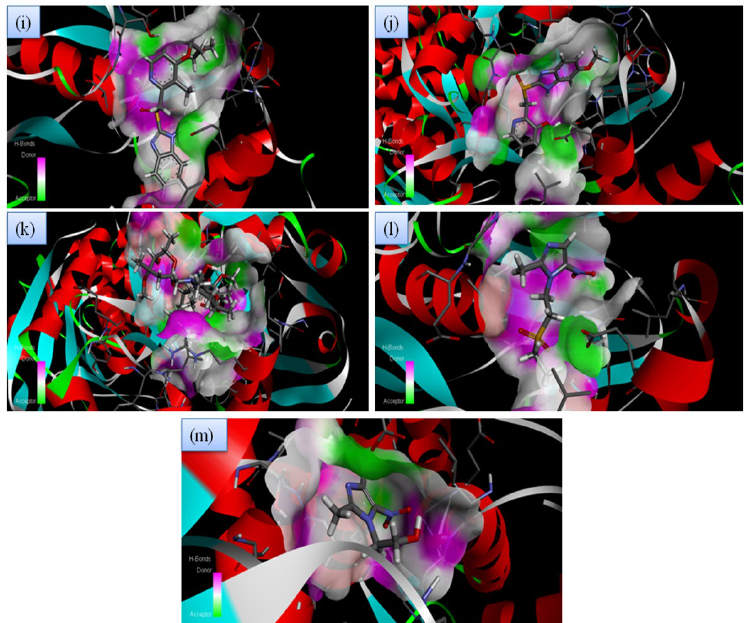
Fig. 3C. H-Bonding interaction of compound with the active site of Chorismate synthase protein (1UMF). (i) Rabeprazole (RBP) (j). Pantoprazole (PPZ). (k) Clarithromycin (CLA). (l) Tinadazole (TIND). (m) Metronidazole